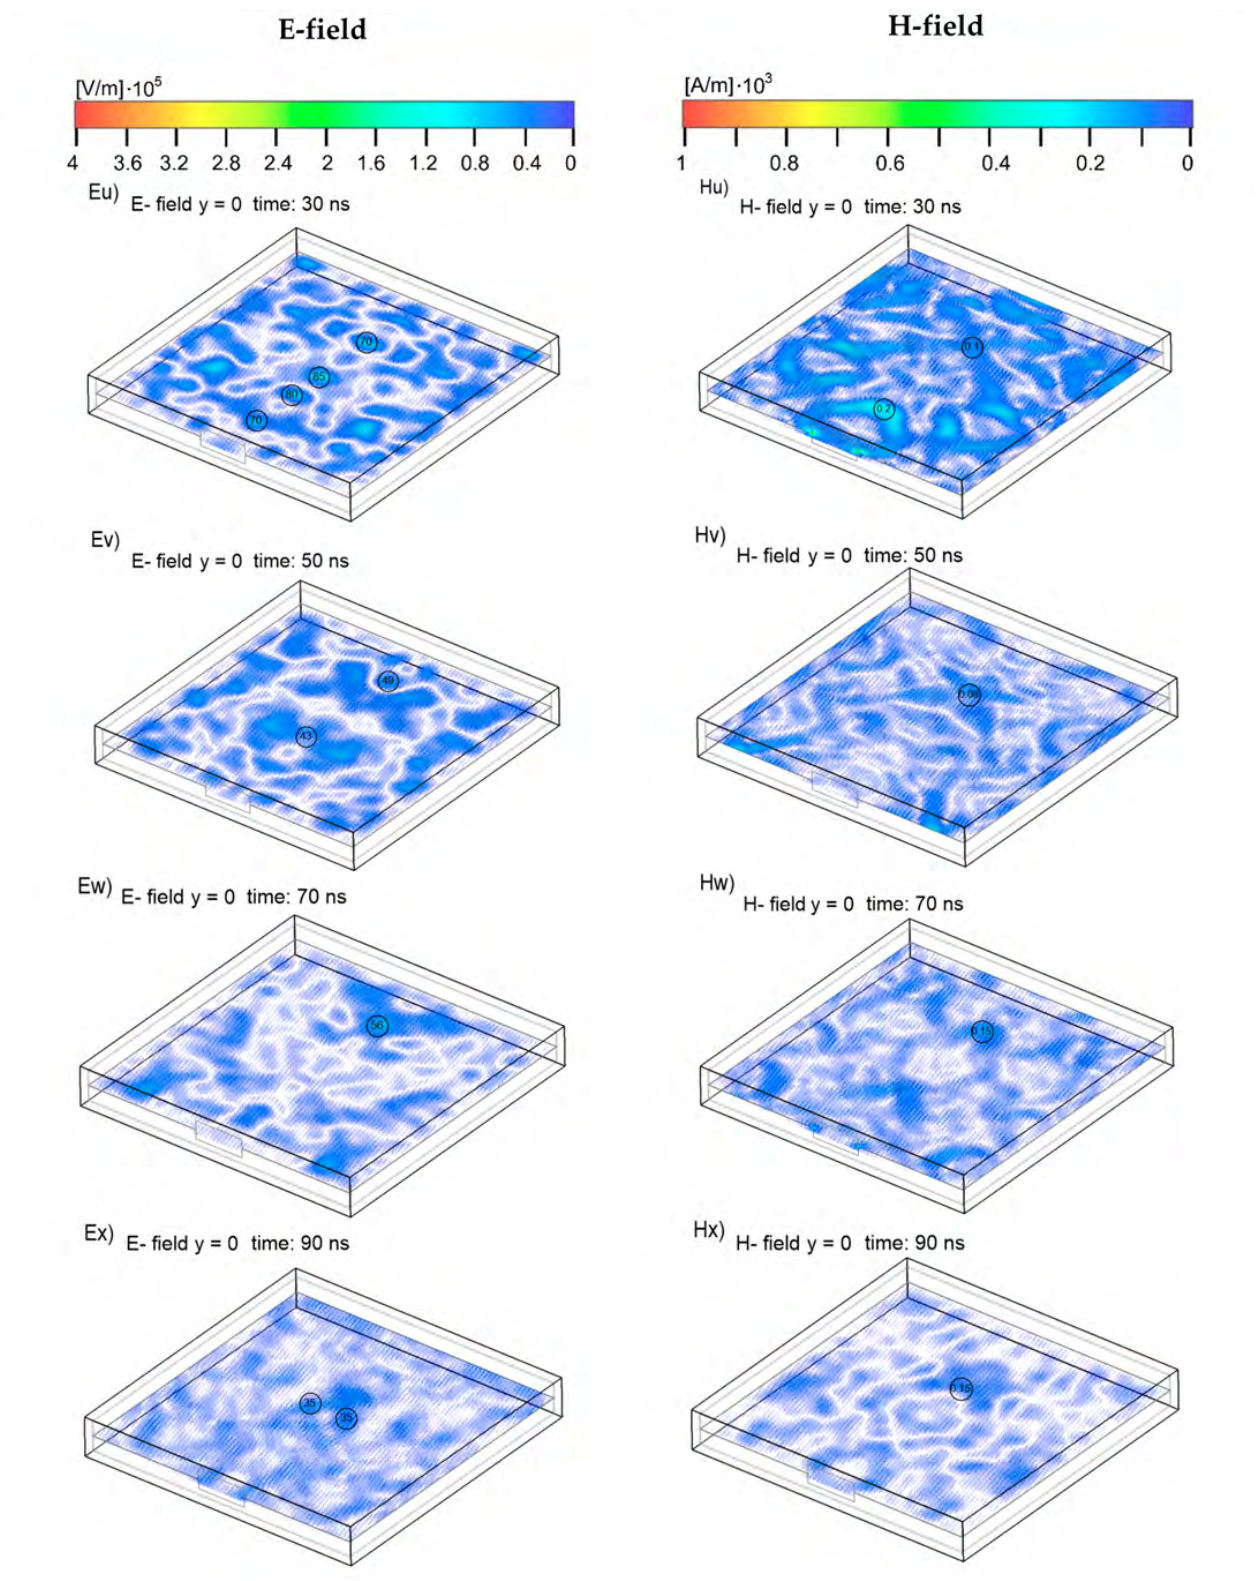
Figure 4. 2D development of the electric and magnetic fields in the enclosure. ( Left column )—the electric field amplitude; ( Right column )—the magnetic field amplitude. The amplitudes of the electric field at 10 5 V/m and magnetic field at 10 3 A/m are given in